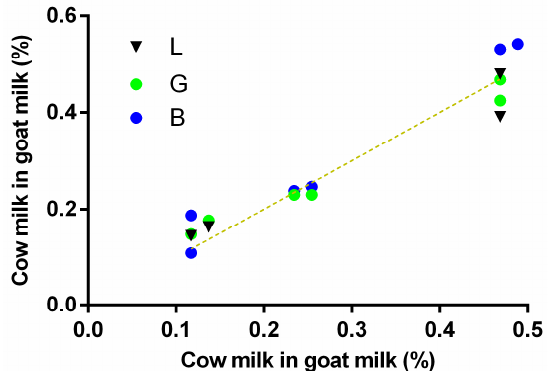
Figure 10. ( a ) G (green balls), B (blue balls), L (black triangles), and V (turquoise squares) channel values were fitted to a calibration curve for LFA quantification of cow milk spiked into pure goat milk. ∆ RGB values (grey diamonds) did not allow to fit to a curve. ( b ) B channel values fitted to a calibration curve and, (inset), linear regression on predictions for cow milk in goat milk at three concentrations (n = 6).